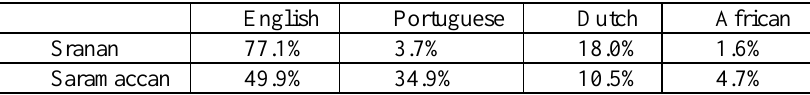
Table 1: etymological origin of Sranan and Saramaccan basic vocabulary (from Smith, 1987).